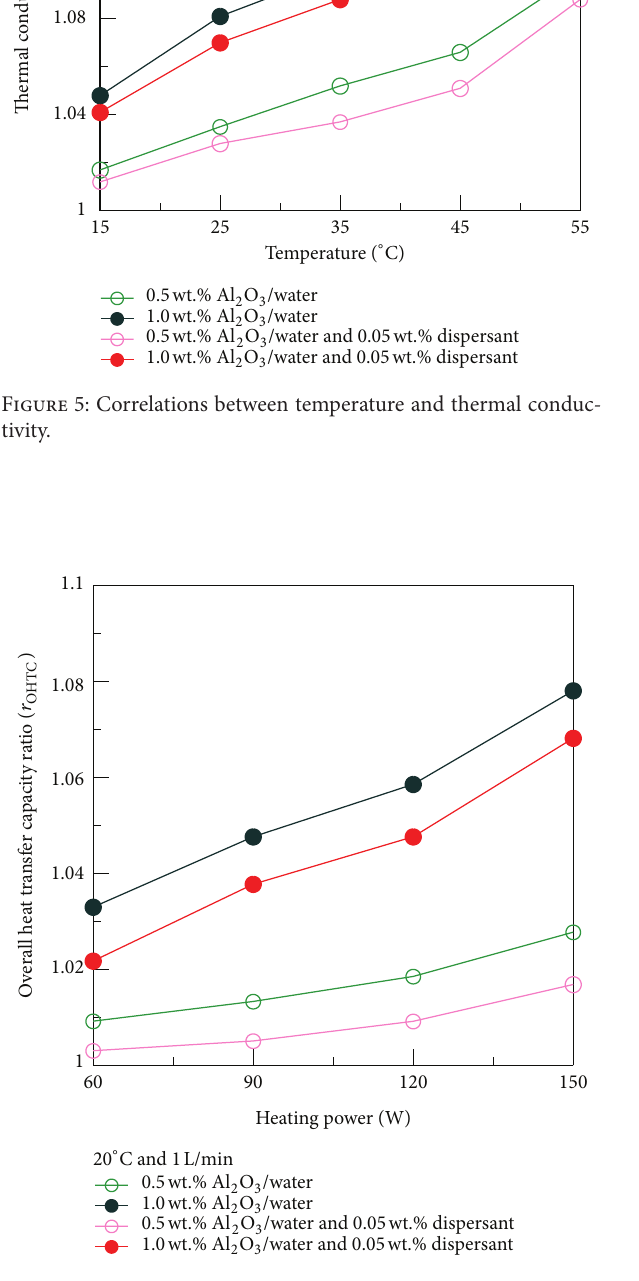
Figure 8: Increment of overall heat transfer capacity (20 ∘ C and 2